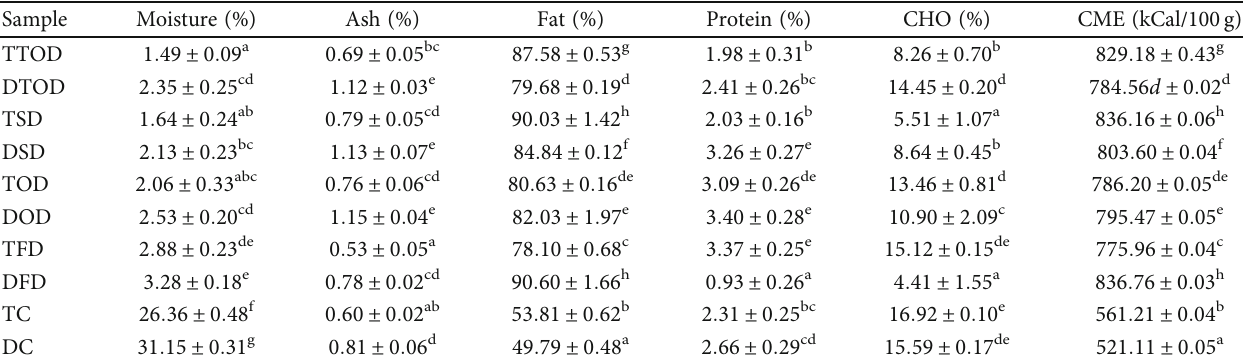
Values represent mean ± SD of at least three replicates. Means in the same column with the same superscript are not signi fi cantly di ff erent ( p > 0 : 05 ). CHO: available carbohydrate; CME: calculated metabolic energy; TTOD: tenera traditional oven dried; DTOD: dura traditional oven dried; TSD: tenera solar dried; DSD: dura solar dried; TOD: tenera oven dried; DOD: dura oven dried; TFD: tenera freeze dried; DFD: dura freeze dried; TC: tenera control; DC: dura control. Table 2: E ff ect of di ff erent drying methods on the physicochemical properties of oil palm fruit mesocarp. Sample